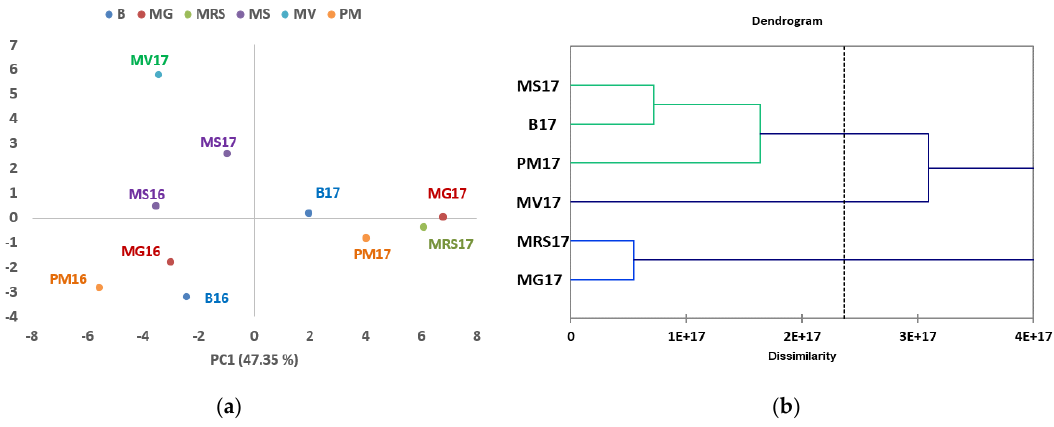
Figure 5. ( a ) PCA based on phytochemical and bioactive UHPLC/MS-MS fingerprints of the fruits of different chestnut cultivars harvested in 2016 and 2017 and ( b ) Dendrogram of the fruits of different chestnut cultivars harvested in 2017 (‘Pr é coce Migoule’—PM, ‘Bournette’—B, ‘Marsol’—MS, ‘Marissard’—MRS, ‘Marigoule’—MG and ‘Maraval’—MV). Statistical analysis based on the qualitative data referring to saturated and unsaturated fatty acids fingerprints of the studied chestnut cultivars harvested in two years was per- formed in order to distinguish some possible groups. The results indicate that there are big differences in the fatty acid composition of chestnuts in different years, which leads to the identification of two distinct groups corresponding to the harvest years (Figure 6a), which suggest that variation in fatty acid composition depended firstly on the climatic conditions and subsequently on genotype. Lower precipitation and higher temperatures favored the accumulation of fatty acids [79]. HCA analysis indicates that, based on fatty acid and derivatives fingerprints, ‘Pr é coce Migoule’ and ‘Bournette’ form a distinct cluster, while ‘Marsol’, ‘Marissard’ and Marigoule are clustered together. ‘Maraval’ shows a distinct fatty acids profile, being clustered separately (Figure 7b).